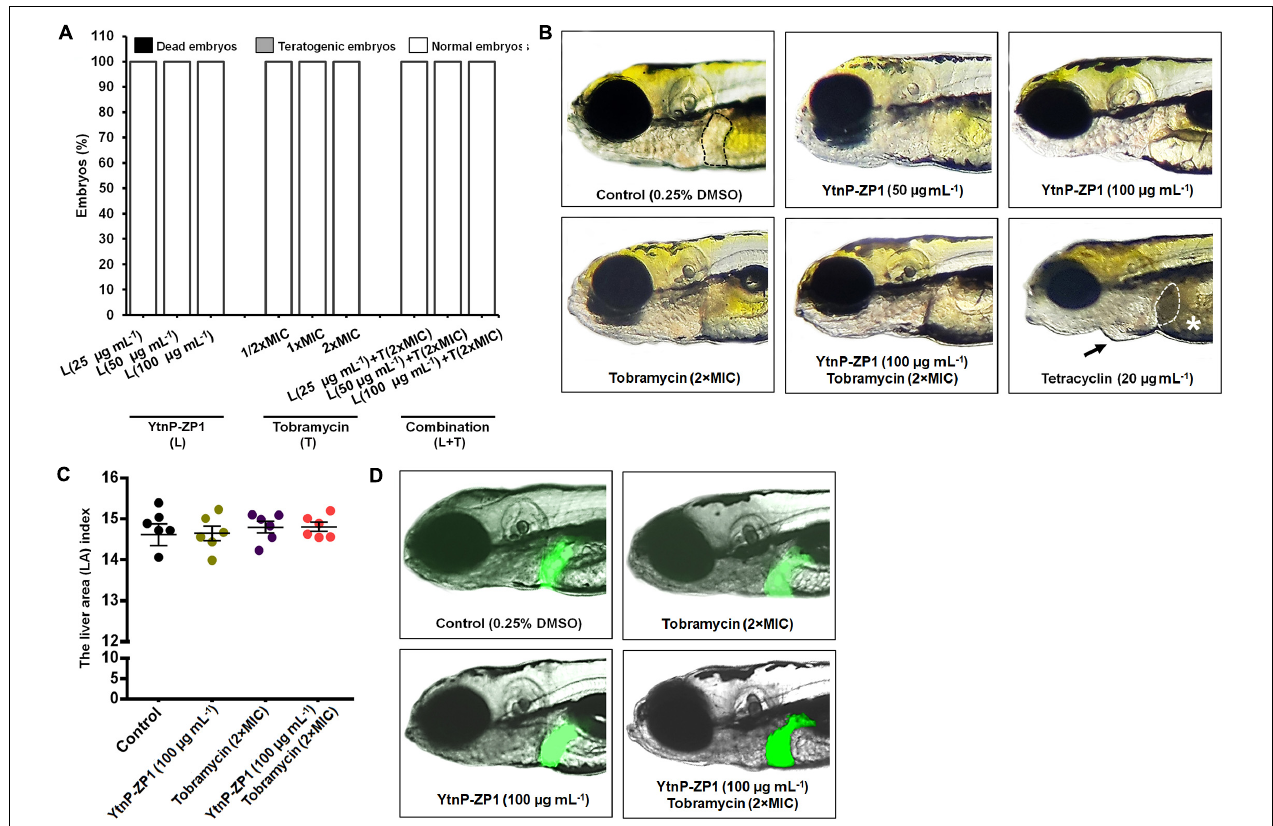
FIGURE 7 | In vivo toxicity evaluation of YtnP-ZP1, tobramycin, and their combination in the zebrafish ( Danio rerio ) model. Acute toxicity was assessed using wild-type embryos exposed to the different doses of enzyme, antibiotic, and their combination (A) . Embryos were treated at 6 hpf and evaluated for survival, teratogenicity, cardiotoxicity, and hepatotoxicity at 120 hpf ( n = 60 per a dose). Normally developed embryos, without signs of hepato- and cardiotoxicity, after exposure to 100 µ g mL − 1 of YtnP-ZP1, 2 × MIC of tobramycin and the combination of 100 µ g mL − 1 lactonase and 2 × MIC tobramycin are shown (B) . The normal (clear) liver in a control embryo is outlined. Tetracycline caused liver necrosis and darkening (dashed outlined), yolk necrosis (asterisk), and pericardial edema (arrow). The hepatotoxicity of the tested enzyme and its combination with antibiotic was additionally verified in zebrafish embryos with fluorescently labeled liver ( n = 6) according to the liver fluorescence (C) and the liver area index (D)